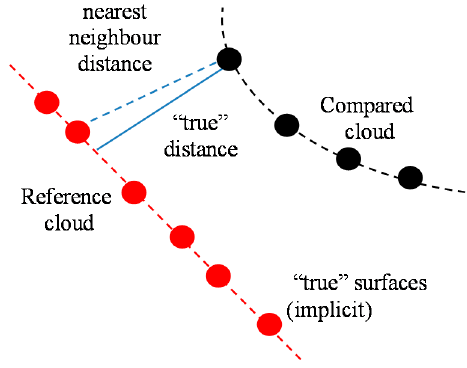
Figure 8. True global model for cloud-to-cloud distances.